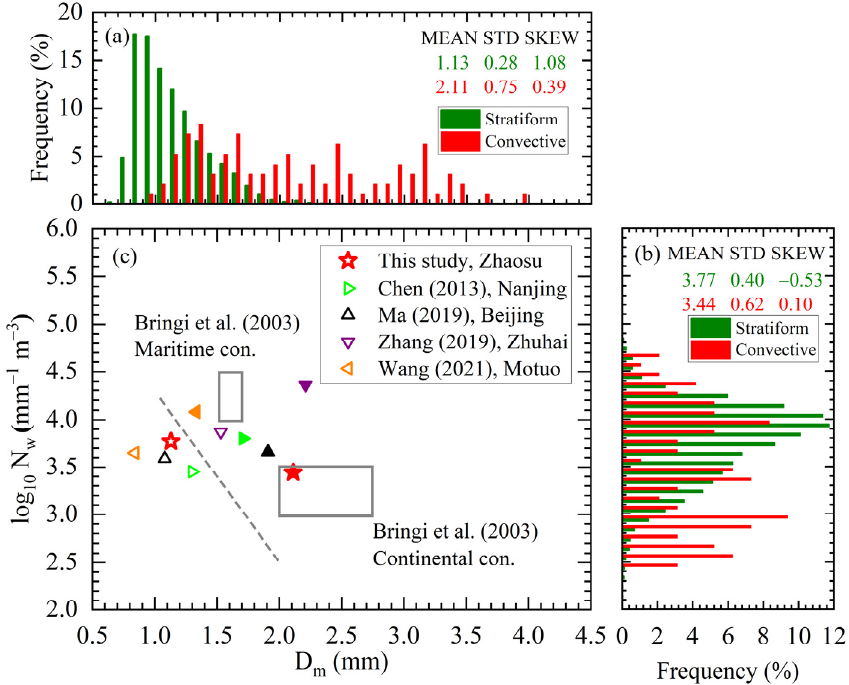
Figure 5. The frequency of histograms of D m ( a ) and log 10 N w ( b ) for the convective rainfall and stratiform rainfall; ( c ) the average log 10 N w versus D m from the present study and other studies with corresponding color symbols. The hollow (solid) symbol corresponds to stratiform (convective) rainfall. The two grey rectangles reflect the continental ‐ like and maritime ‐ like clusters for convective rainfall, reported by Bringi et al. [20], and the dotted line represents their stratiform rainfall cases.